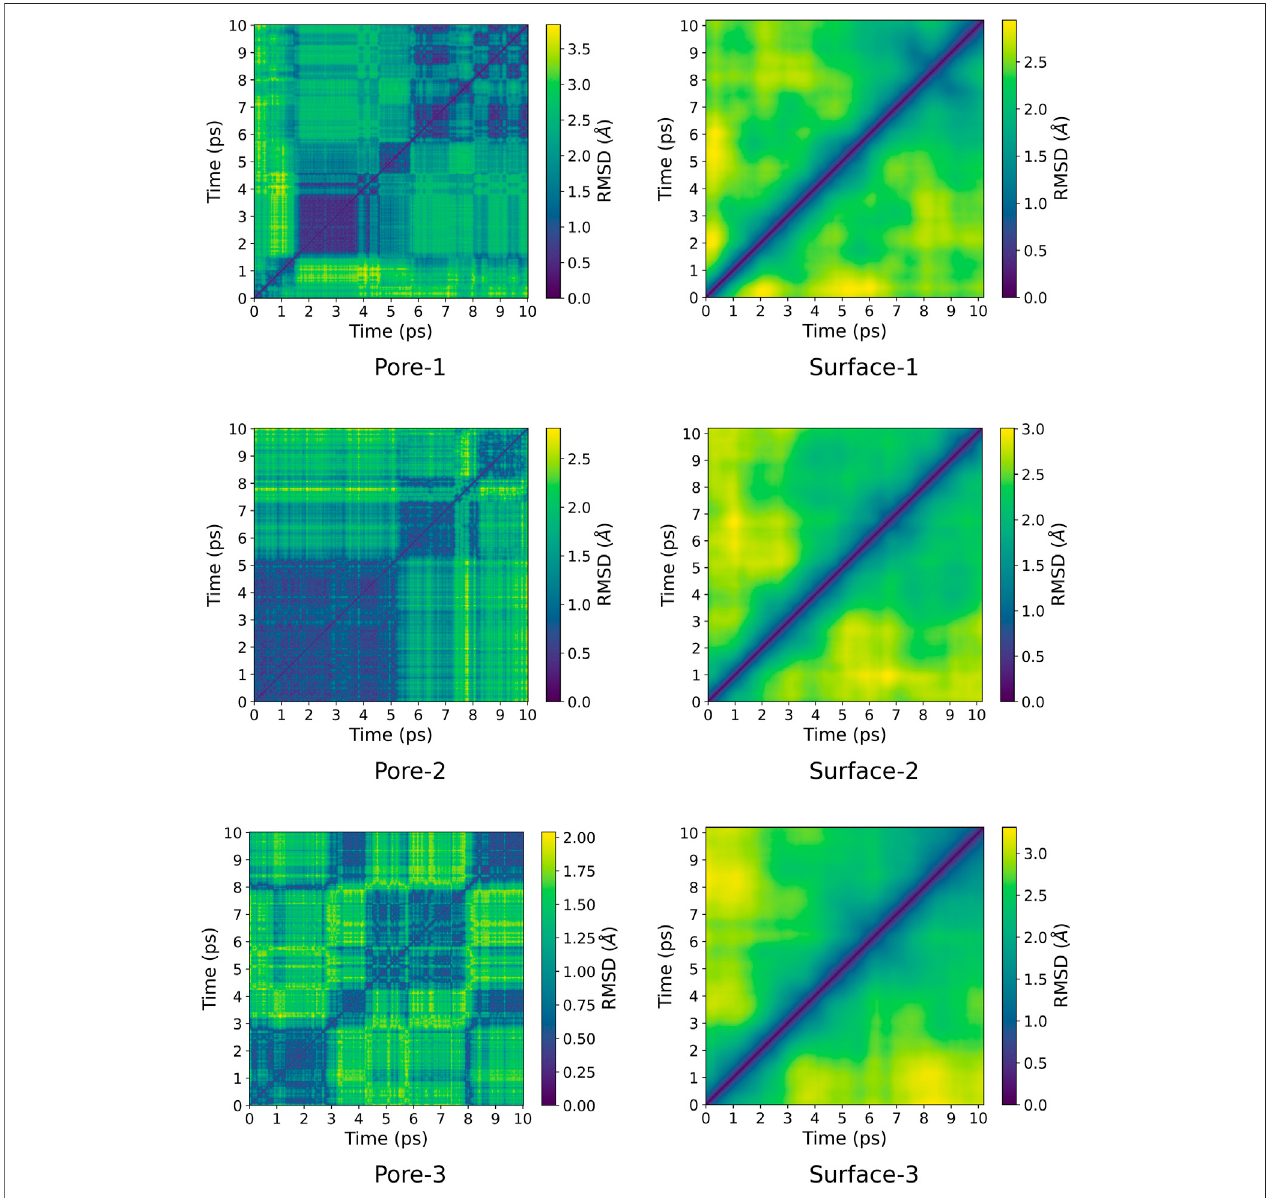
FIGURE 2 | Pairwise RMSD plot for ZnPW I EDOT interactions for both nano-channel and surface interaction.The colour gradient corresponds to the RMSD in Å. The labels ” Pore ” and ” Surface ” correspond to nano-channel and surface interactions respectively and the numbers after the hyphen correspond to the number of monomer(s)